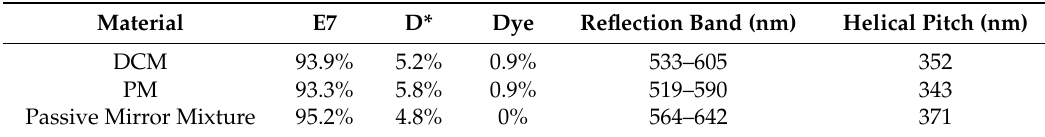
Table 3. Composition and band-gap range of the studied CLC